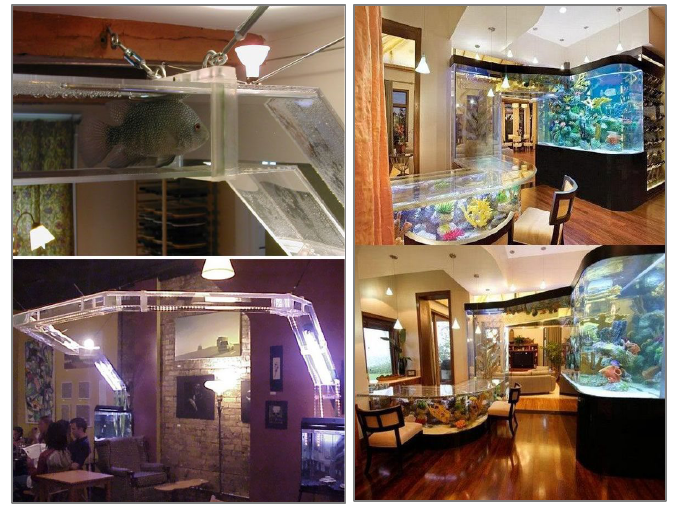
Figure 16 Common living area created with aquarium and tanks